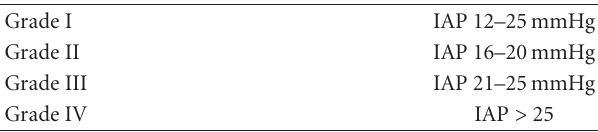
Table 1: Grading of intra-abdominal hypertension (WSACS con- sensus definitions, 2004).